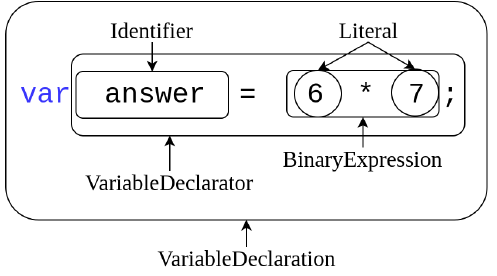
Figure 4. How we break down a single JavaScript statement into an